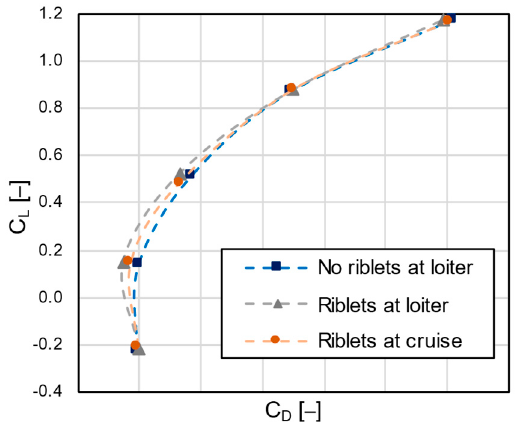
Figure 12. Drag polar of the HCUAV RX-1 with and without riblets at loiter and cruise conditions.